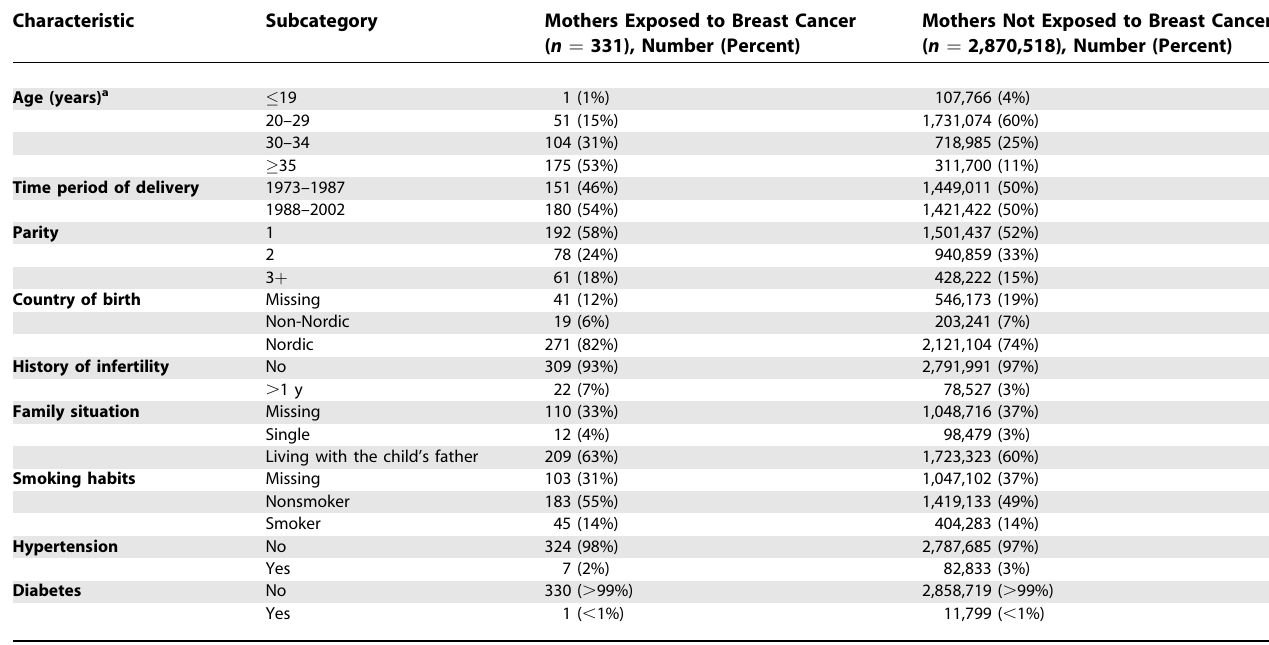
Table 1. Characteristics of Women Delivering the First Infant Subsequent to Breast Cancer Compared with the General Population of Women Delivering